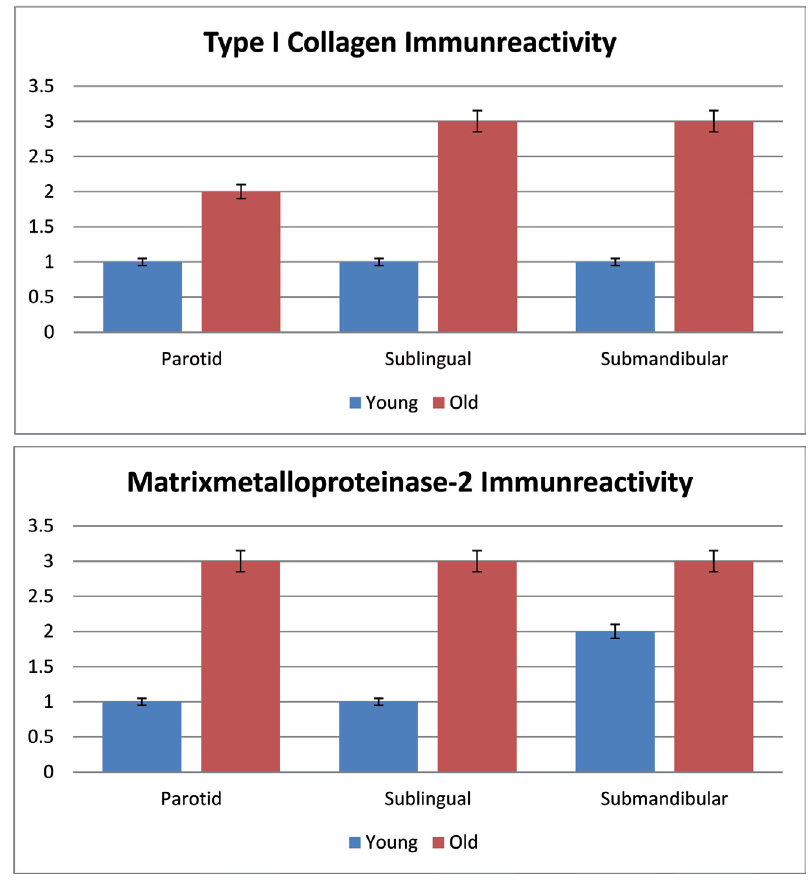
Figure 5- Comparison of immunreactivity of MMP-2 and type I collagen in major salivary gland of young and old mice